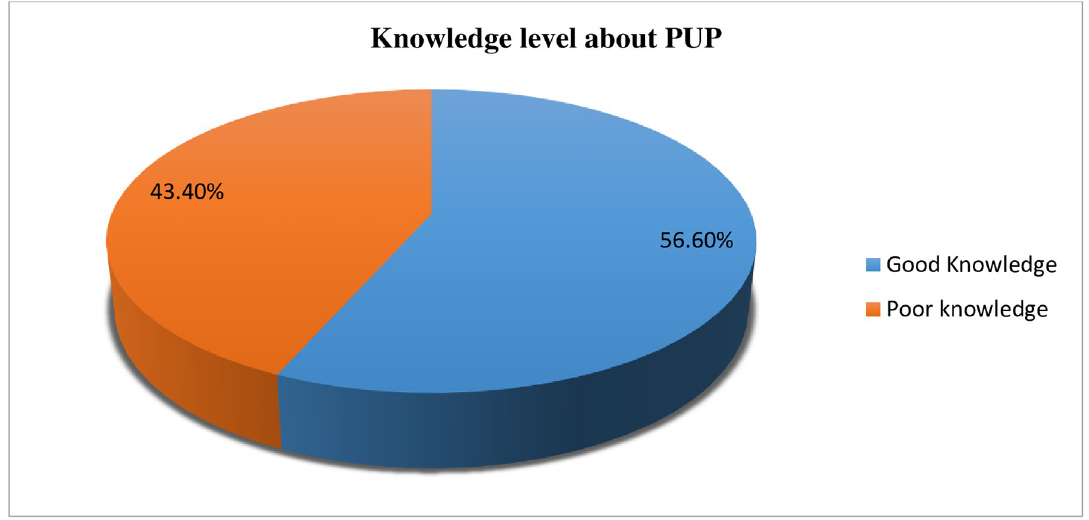
Fig 2. Nurses knowledge about pressure ulcer prevention in public hospitals of Harari regional state and Dire Dawa city administration, Eastern Ethiopia, 2018 (n = 401).